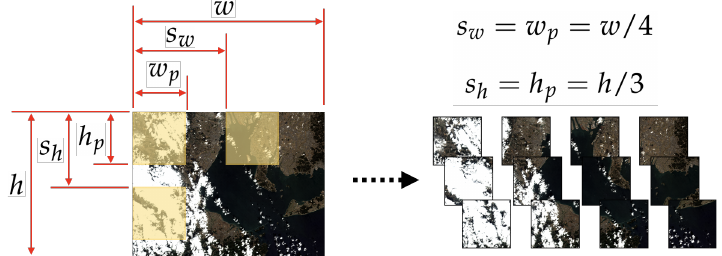
Figure 3. An example of patch decomposition with 16 × 16 × 3 patch and a 16 × 16 stride on a 64 × 48 × 3 image. The patch decomposition results in 12 patches as shown on the right-hand side of the